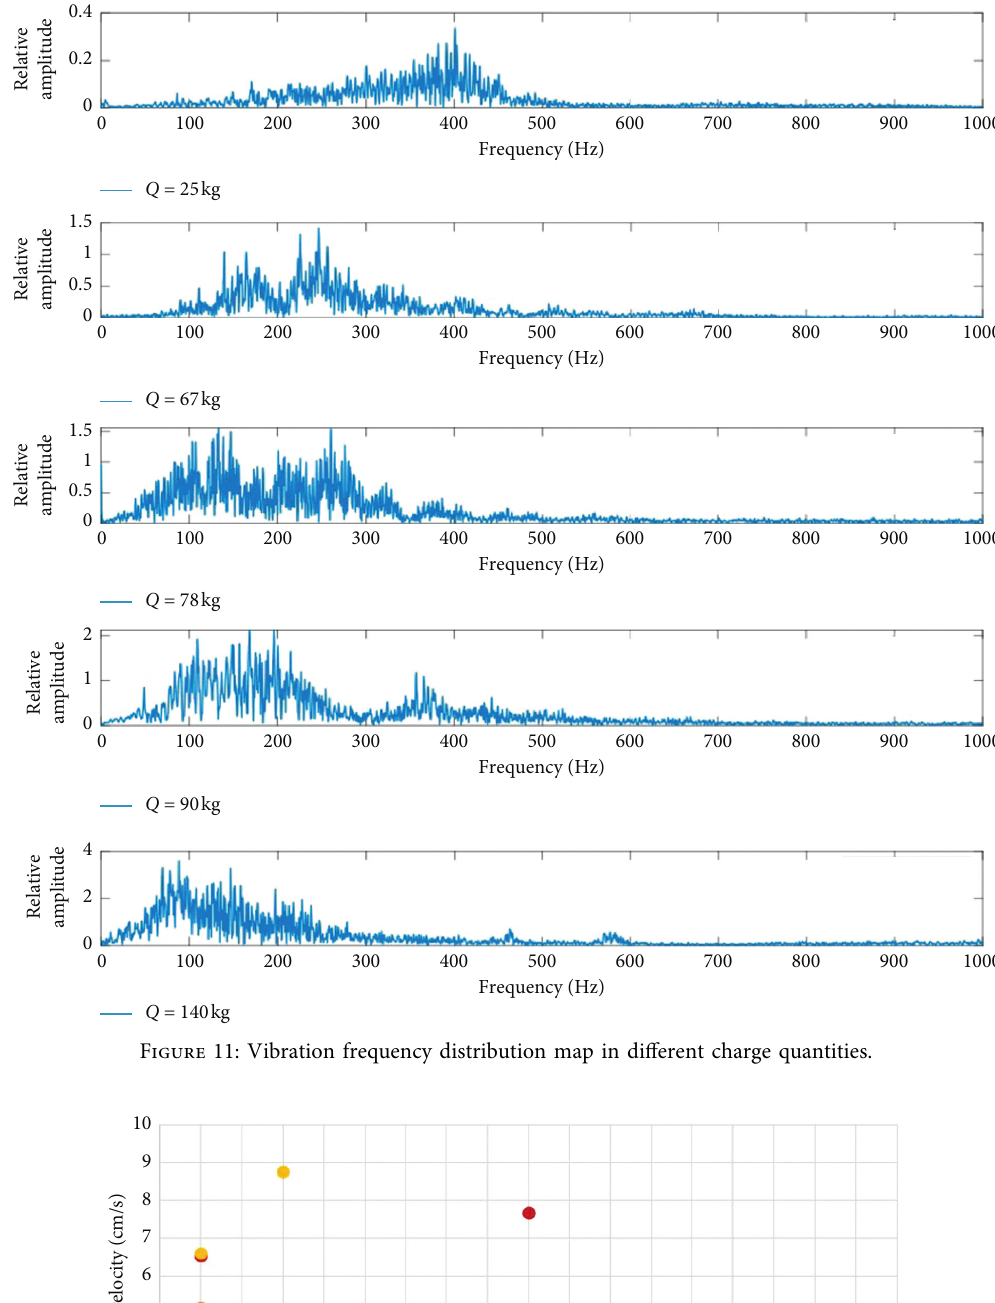
Figure 11: Vibration frequency distribution map in different charge quantities.